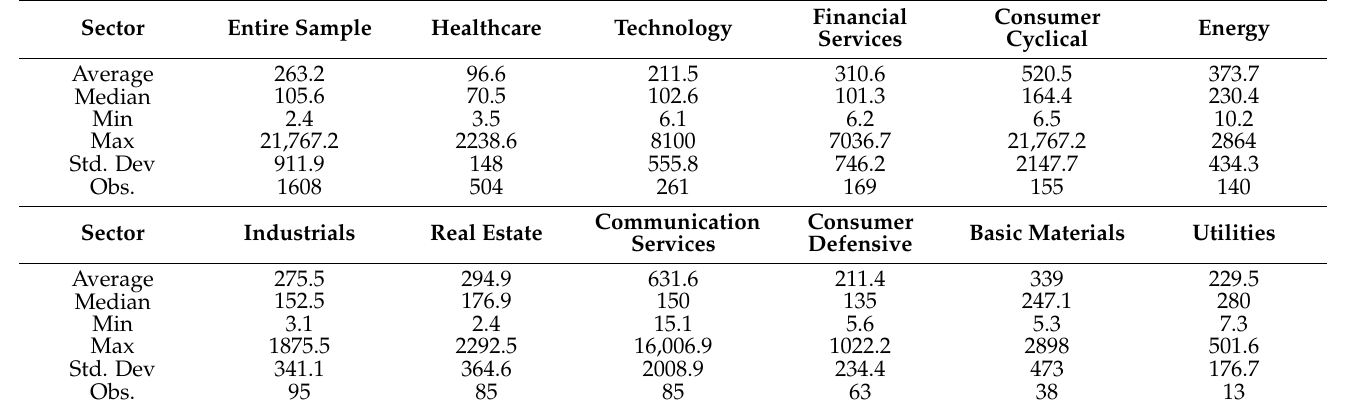
Panel H: Funds Raised by the Firms by Sector (USD